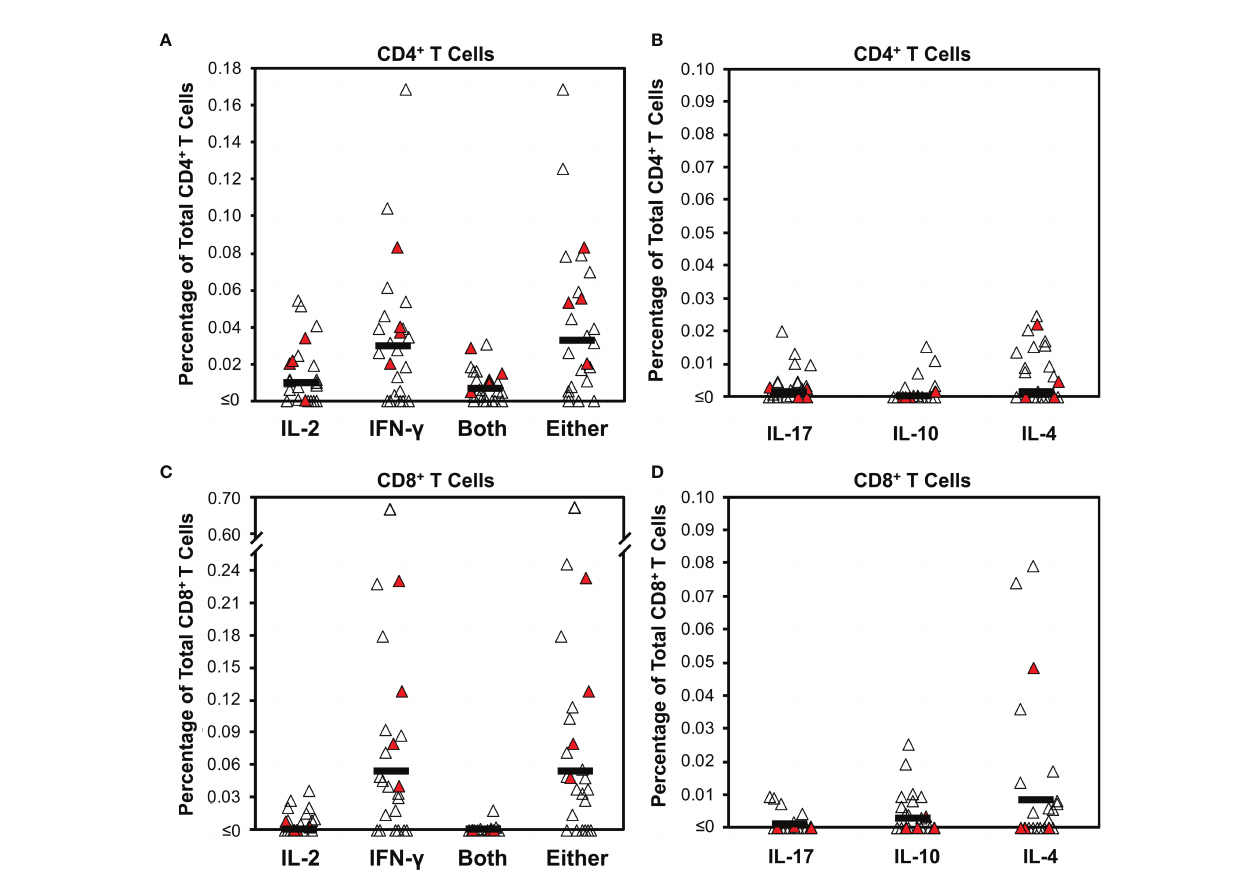
FIGURE 1 | Intracellular cytokine staining for T cell responses against SARS-CoV-2 early after infection demonstrates bias for IFN- g production. Cytokine production was determined by intracellular cytokine staining for CD4 + and CD8 + T cell subsets after stimulation with a pool of overlapping peptides spanning spike combined with predicted CD4 + epitopes from across the proteome ( Supplementary Figure S1 ) for 25 persons (21 with mild infection, 4 with severe infection) a mean of 29.8 days from COVID-19 symptom onset (range 15 to 49 days). Filled symbols indicate persons who had severe infection. (A) The background-subtracted frequencies of CD4 + T cells producing IL-2, IFN- g , both cytokines, or either cytokine are plotted. Dark horizontal bars indicate means, which were 0.010%, 0.030%, 0.007%, and 0.033%, respectively. De fi ning responses as being ≥ 0.01% above background, responders for these four cytokine response groupings were 12/25 (48%), 17/25 (68%), 10/25 (40%), and 18/25 (72%), respectively. (B) The background-subtracted frequencies of CD4 + T cells producing IL-17, IL-10, or IL-4 are plotted. Dark horizontal bars indicate means, which were 0.003%, 0.002%, and 0.007%, respectively. De fi ning responses as being ≥ 0.01% above background, responders for these three cytokine responses were 3/26 (11.5%), 2/26 (7.7%), 10/25 (40%), and 7/26 (26.9%), respectively. (C) The background-subtracted frequencies of CD8 + T cells producing IL-2, IFN- g , both cytokines, or either cytokine are plotted. Dark horizontal bars indicate means, which were 0.001%, 0.053%, 0.000%, and 0.054%, respectively. De fi ning responses as being ≥ 0.01% above background, responders for these four cytokine response groupings were 6/25 (24%),17/25 (68%), 1/25 (4%), and 20/25 (80%), respectively. (D) The background-subtracted frequencies of CD8 + T cells producing IL-17, IL-10, or IL-4 are plotted. Dark horizontal bars indicate means, which were 0.002%, 0.004%, and 0.012% respectively. De fi ning responses as being ≥ 0.01% above background, responders for these three cytokine responses were 0/26 (0%), 3/26 (11.5%), 10/25 (40%), and 6/26 (23.1%),